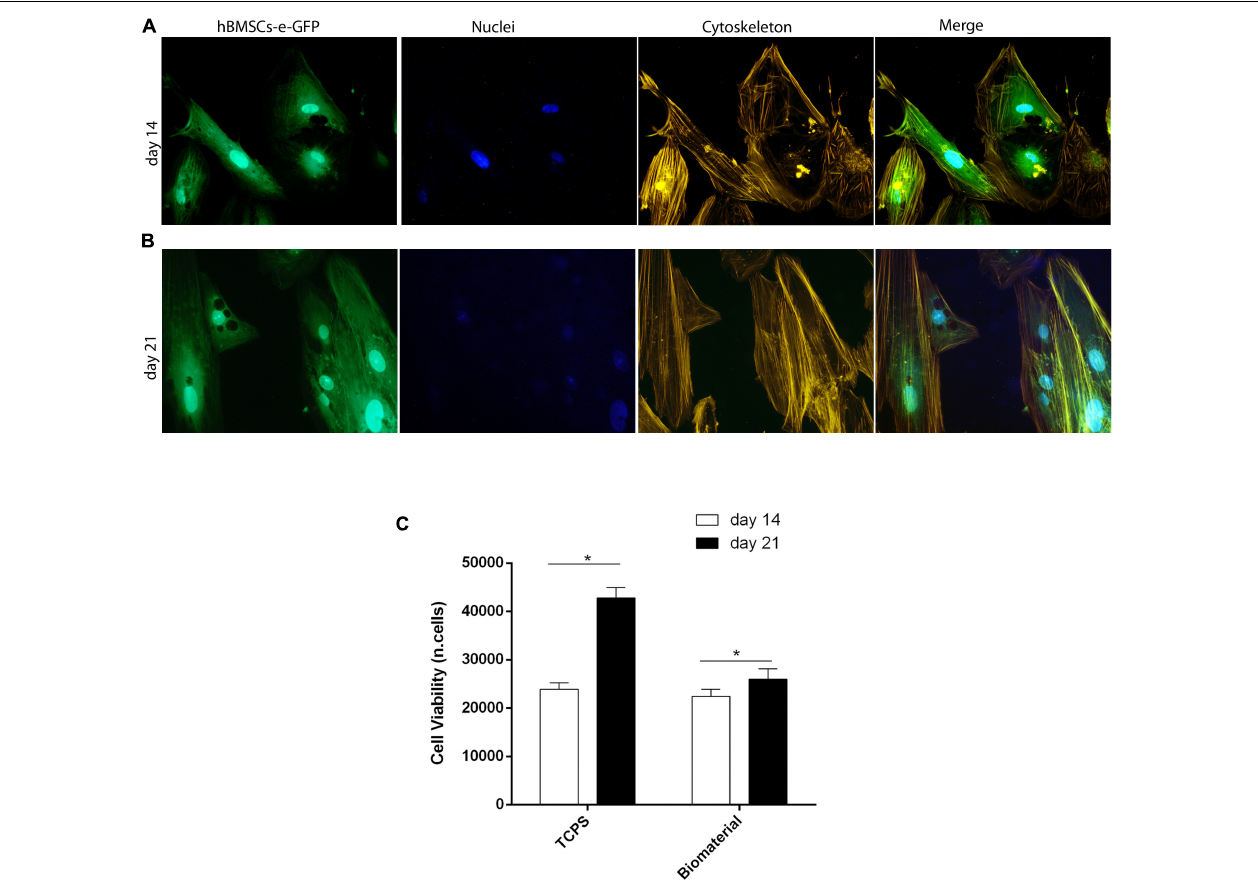
FIGURE 4 | Stem cell viability, cytoskeleton architecture, and metabolic activity of human bone marrow-derived mesenchymal stem cells (hBMSCs) grown on scaffold. (A) Cytoskeleton architecture of recombinant hBMSC-enhanced green fluorescent protein (eGFP) cultures grown on the biomaterial, at day 14 (T1). (B) In this panel, actin filaments of hBMSC-eGFP grown on the biomaterial at day 21 do not show alteration in the structural organization compared to day 14, suggesting a good compatibility of the scaffold (magnification 20 × ). (C) hBMSC metabolic activity measured by AlamarBlue assay at days 14 and 21 of cultivation on the biomaterial. Statistically significant differences are evident between hBMSCs grown on biomaterials at days 14 and 21 (* p < 0.05). Tissue culture polystyrene (TCPS) exhibited the highest value in cell viability at day 21.